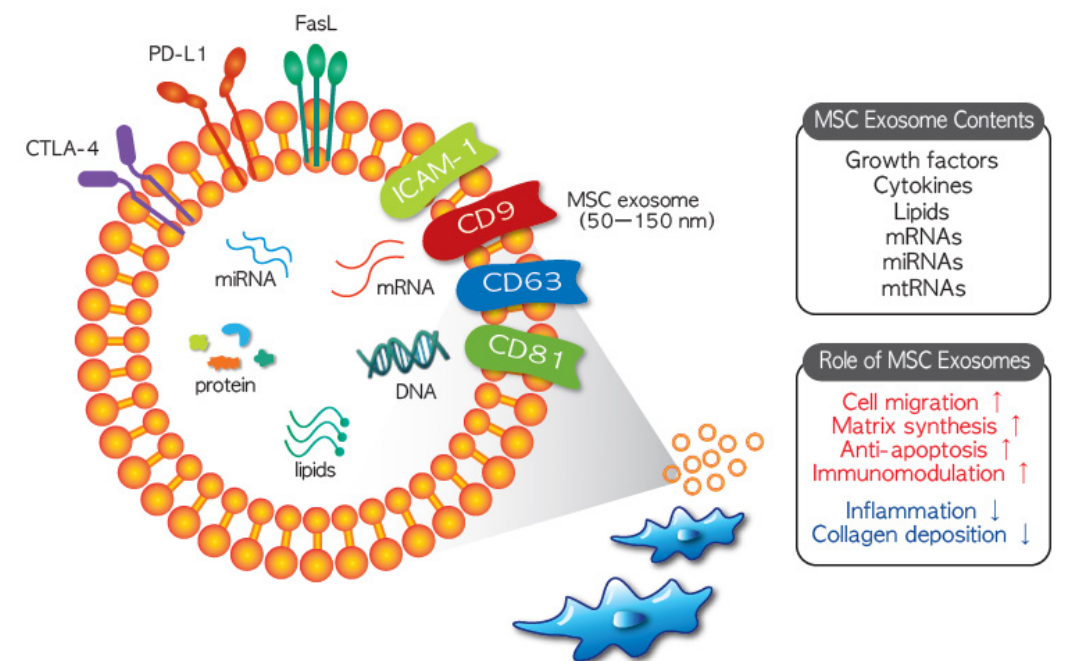
Figure 1. Composition and therapeutic function of MSC (mesenchymal stem cells) exosomes. Exosomes derived from MSCs may contain growth factors, cytokines, DNA, lipids, mRNAs, miRNAs, and mtRNAs. Similar as their cells from which they originated, MSC exosomes possess therapeutic properties including stimulation of cell migration and extracellular matrix synthesis, anti-apoptotic effects, immunomodulation and anti-inflammatory effects, and stimulation of collagen deposition. Due to these distinctive therapeutic features, the feasibility of MSC exosome therapy is currently being assessed in several clinical studies.